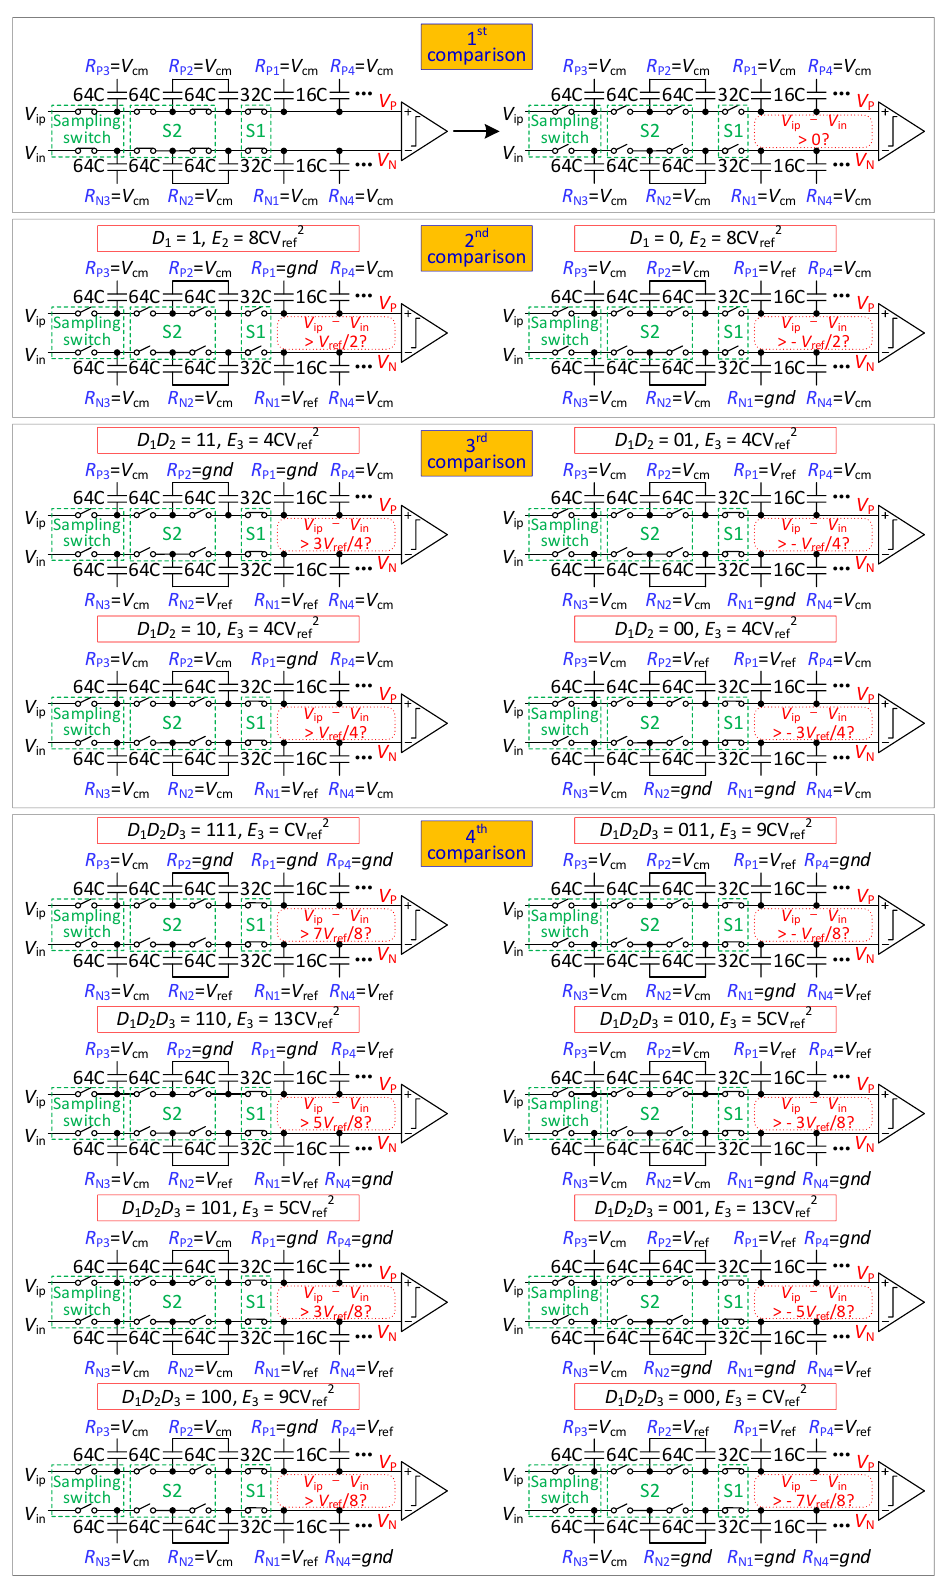
Figure 3. Proposed 9-bit mode switching scheme.